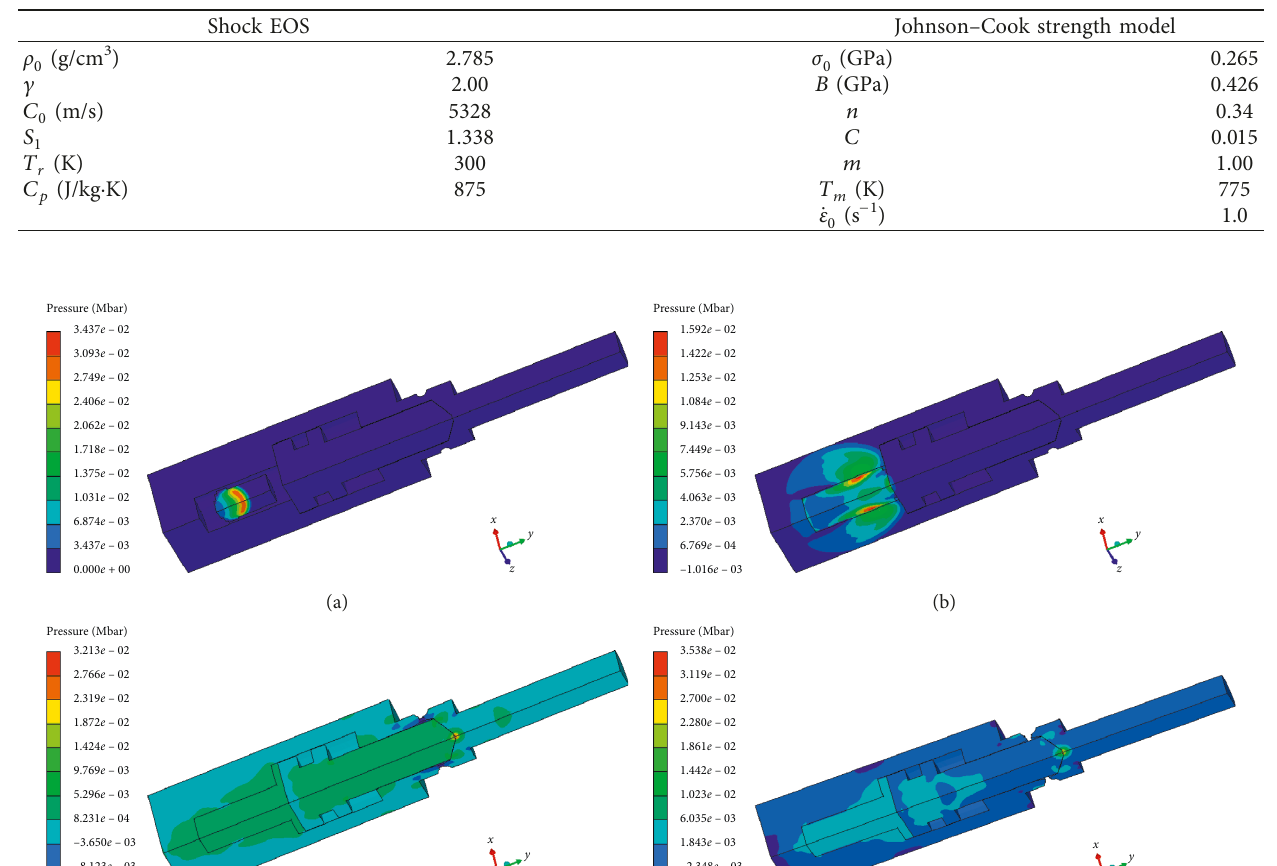
Table 3: Material parameters of 2024 aluminum.